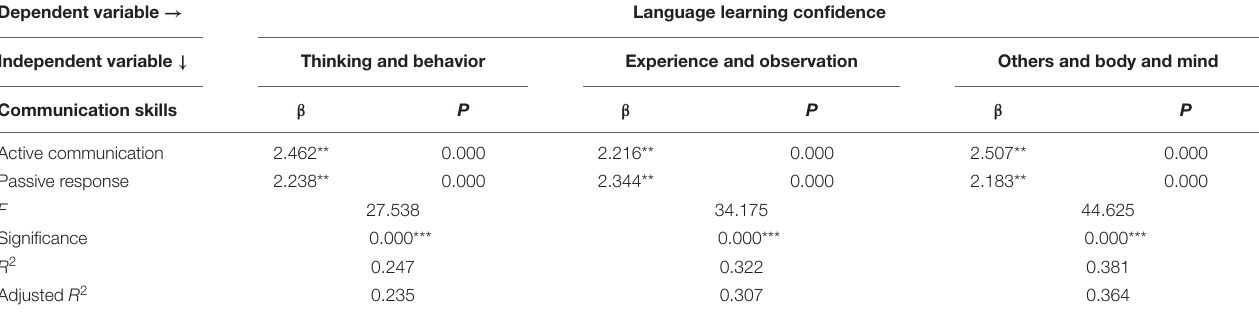
TABLE 3 | Correlation analysis of communication skills and language learning